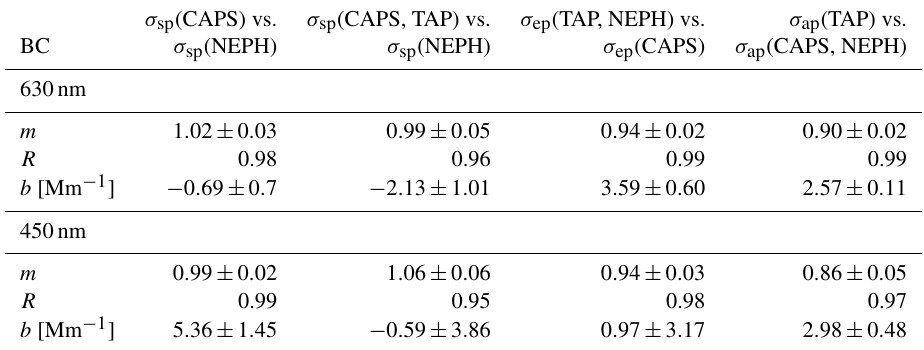
Table 7. Linear regression results of scattering ( σ sp ), extinction ( σ ep ) and absorption ( σ ap ) coefficients for external mixtures of BC and AS particles, given as slopes ( m ), Pearson R and y axis intercepts ( b ). σ sp (CAPS) vs. σ sp (CAPS, TAP) vs. σ ep (TAP, NEPH) vs. σ ap (TAP) vs. BC σ sp (NEPH) σ sp (NEPH) σ ep (CAPS) σ ap (CAPS, NEPH)